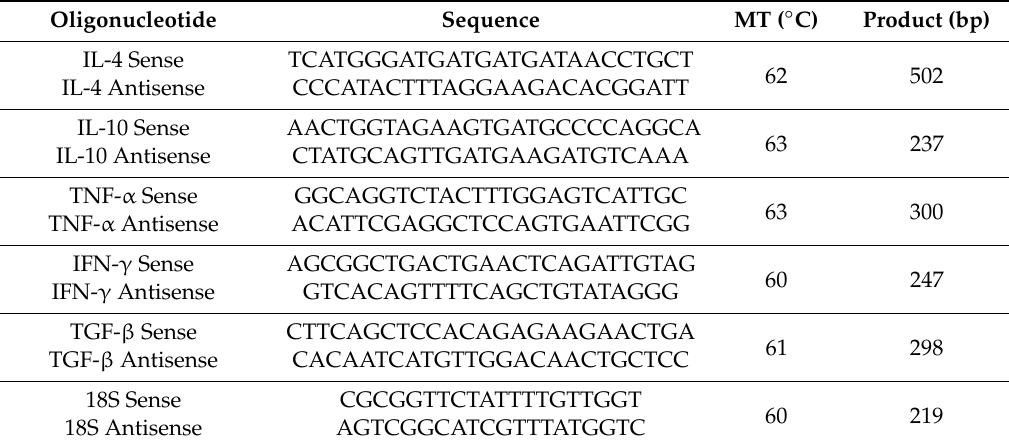
Table 1. Oligonucleotide sequences used for